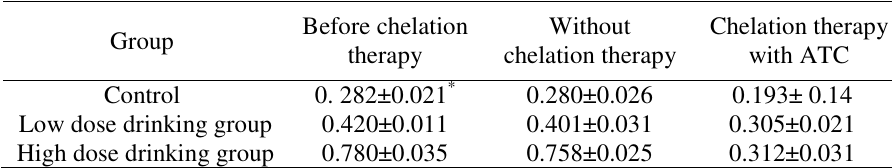
Table 2. The results of cadmium content in various tissues of rats before and after chelation therapies with ATC are as